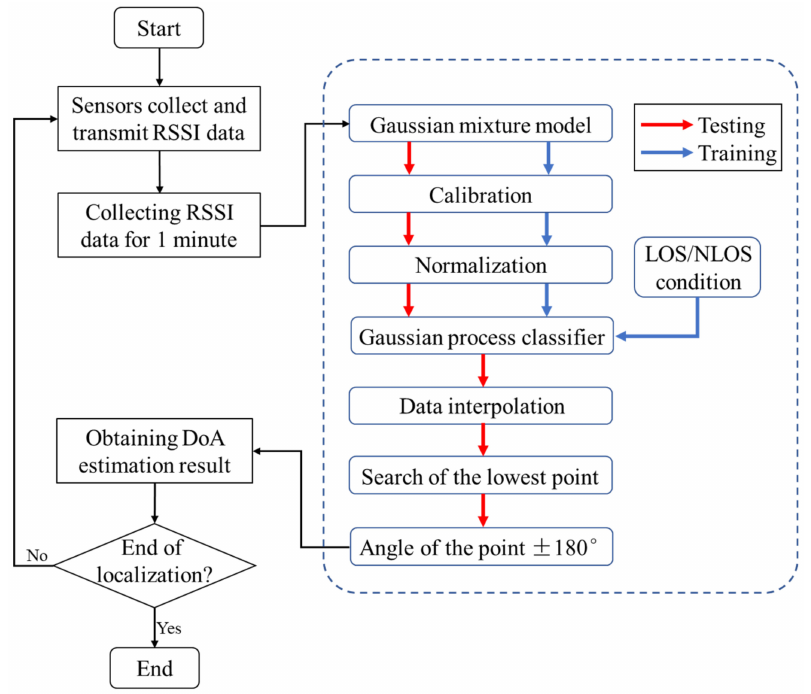
Figure 7. Flow chart of the proposed direction of arrival (DoA) estimation